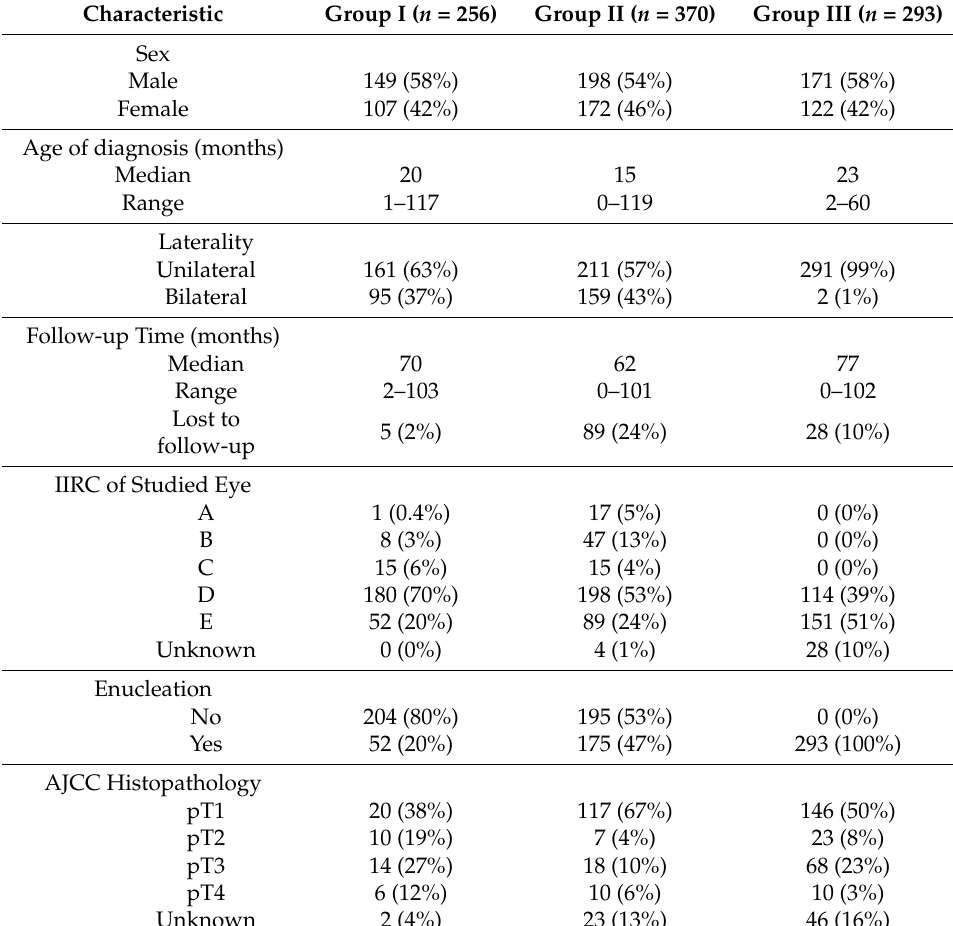
Table 1. Baseline clinical